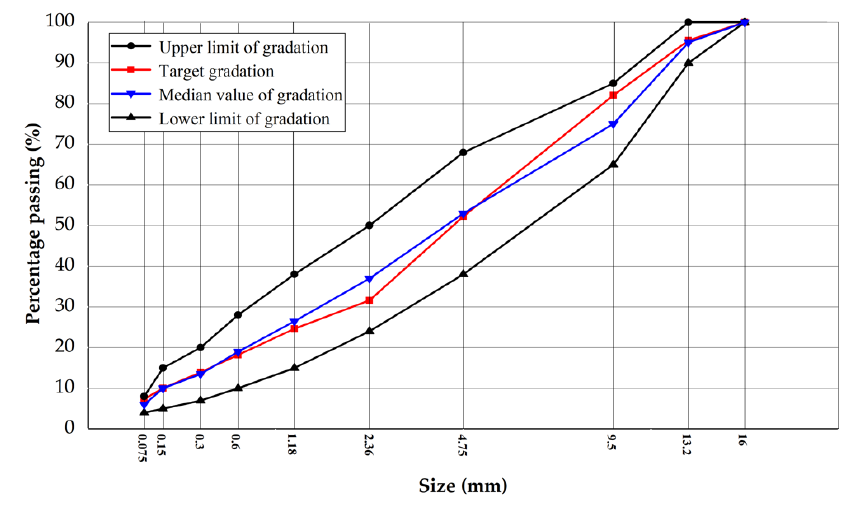
Figure 1 Gradation curves of the asphalt concretes. Figure 1. Gradation curves of the asphalt